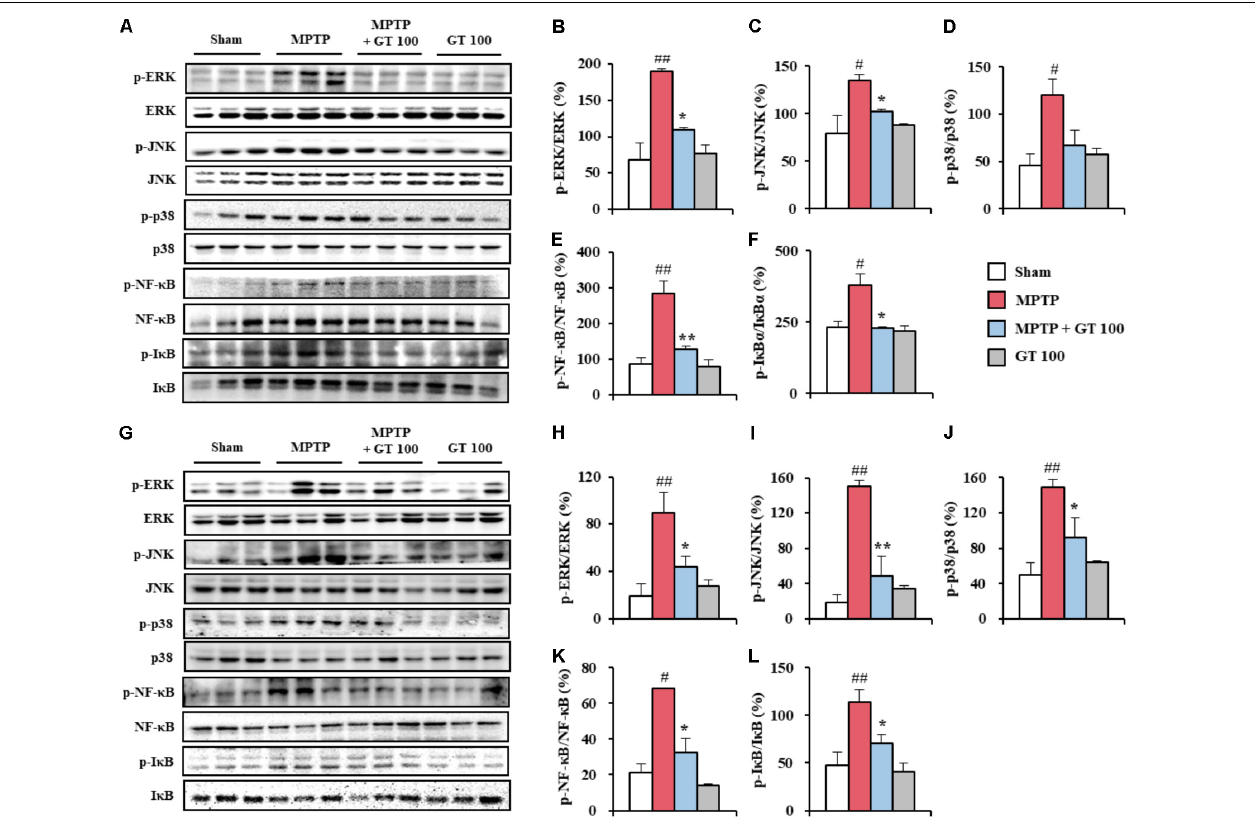
FIGURE 3 | Gintonin inhibits MAPKs and NF- κ B signaling pathways in the SNpc and striatum after MPTP injection. (A–L) SNpc and striatum sample from each group ( n = 3 per group) 7 days after MPTP-injection were quantified by immunoblot analysis to measure the alteration in the MAPKs (A–D,G–J) and NF- κ B pathways (A,E,F,G,K,L) . SNpc (A–F) and striatum (G–L) . The left panels illustrate representative Western blots (A,G) . ANOVA test; # p < 0.05 and ## p < 0.01 vs. Sham group. ∗ p < 0.05 and ∗∗ p < 0.01 vs. MPTP